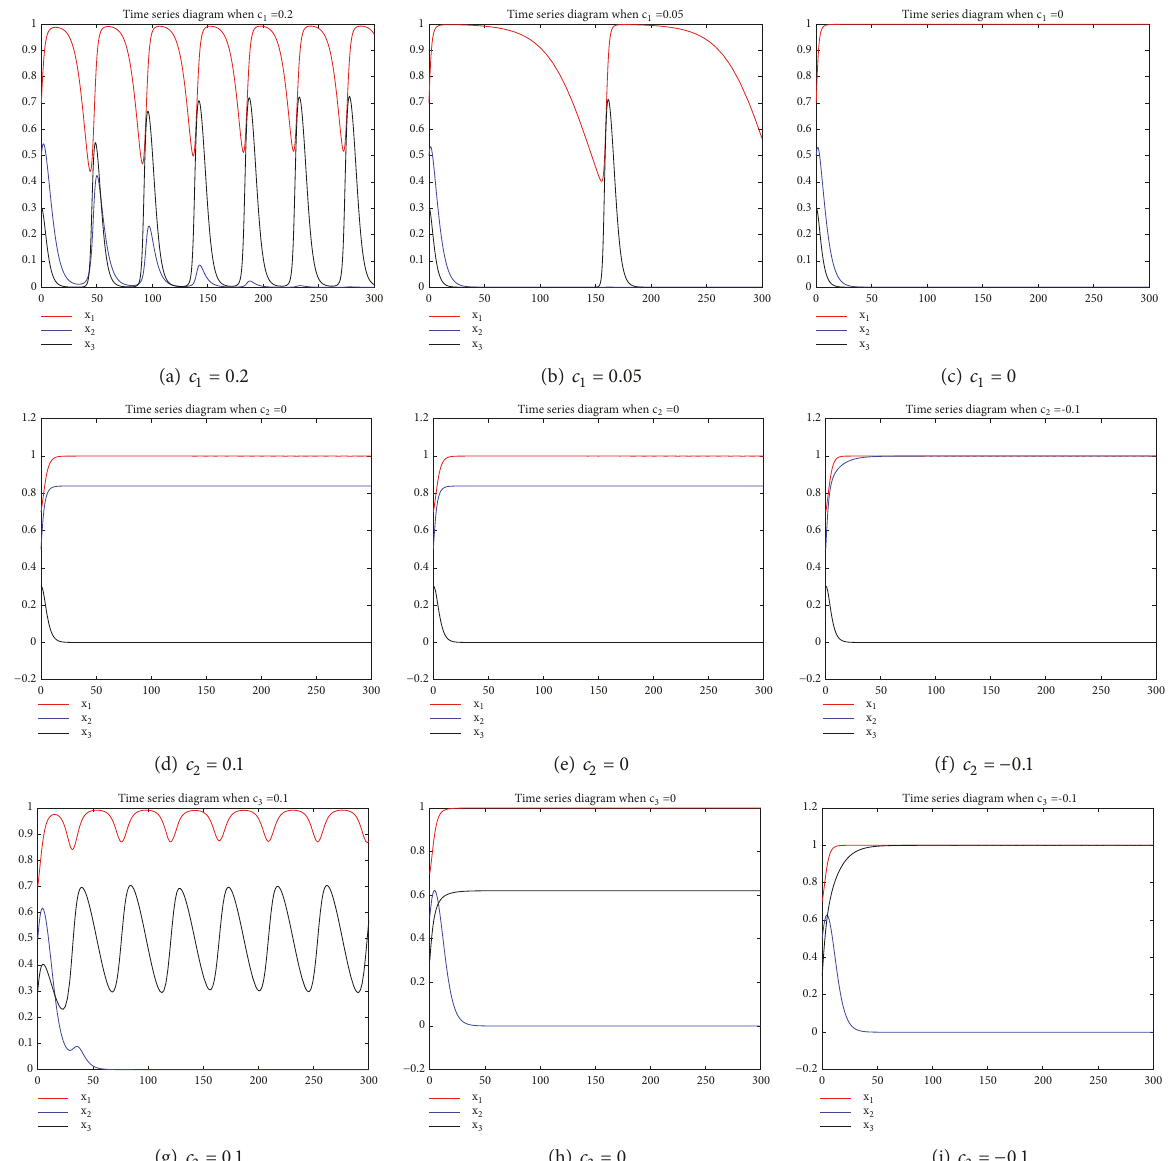
Figure 2: Time series graph of players’ strategy selection probabilities when 𝑐 1 ,𝑐 2 ,𝑐 3 have smaller values separately. Initial values of variables: (𝑥 , 𝑥 , 𝑥 )| = 𝑃 (0.7,0.5,0.3) 1 2 3 𝑡=0 1